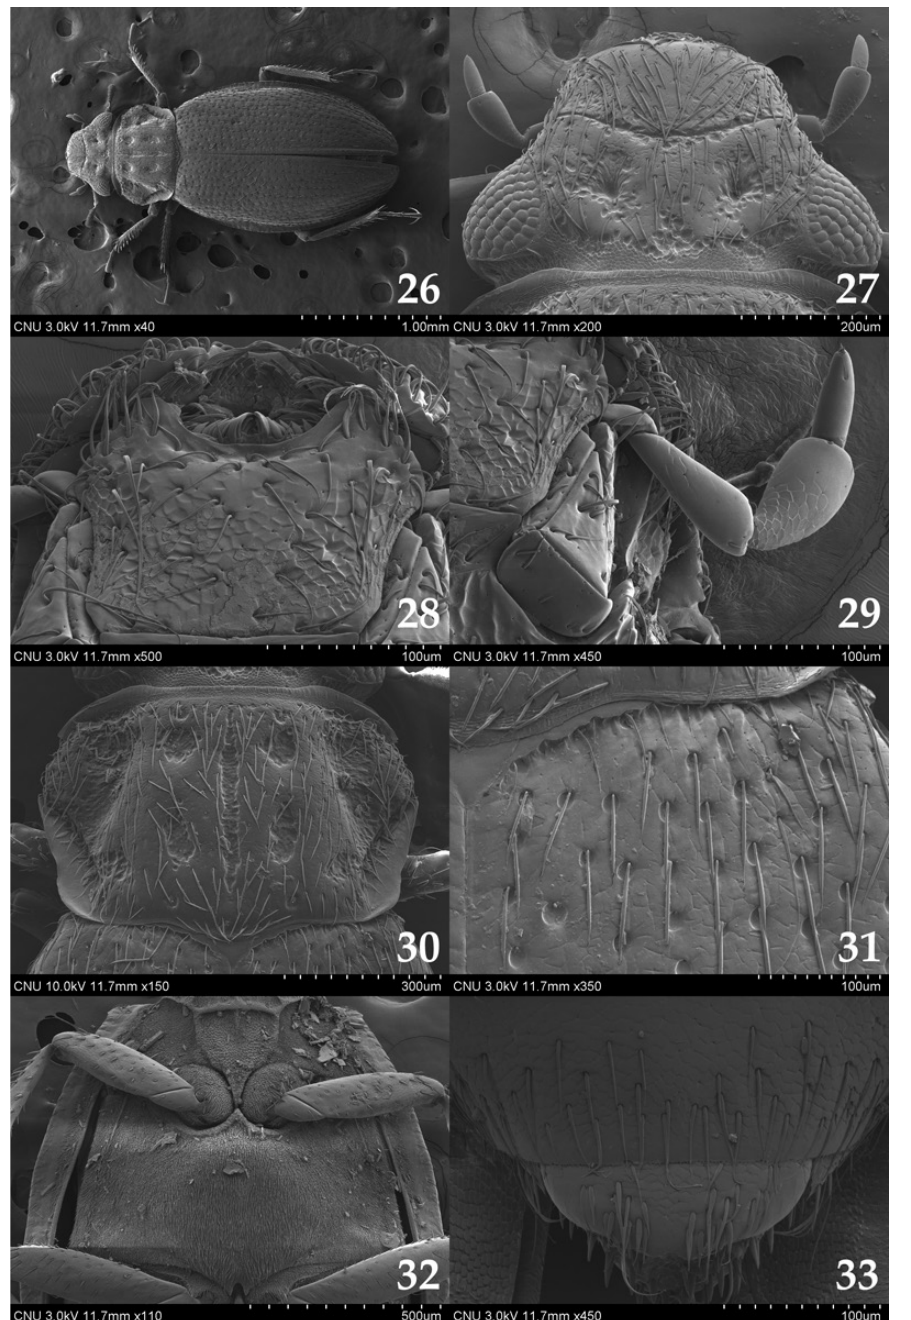
Figures 26–33. Ochthebius lobatus . 26 body (dorsal aspect) 27 head (dorsal aspect) 28 mentum (ventral aspect) 29 maxillary palpus (dorsal aspect) 30 pronotum (dorsal aspect) 31 anterior part of elytron (dorsal aspect) 32 meso– and metaventrite (ventral aspect) 33 sternites VIII–IX (ventral